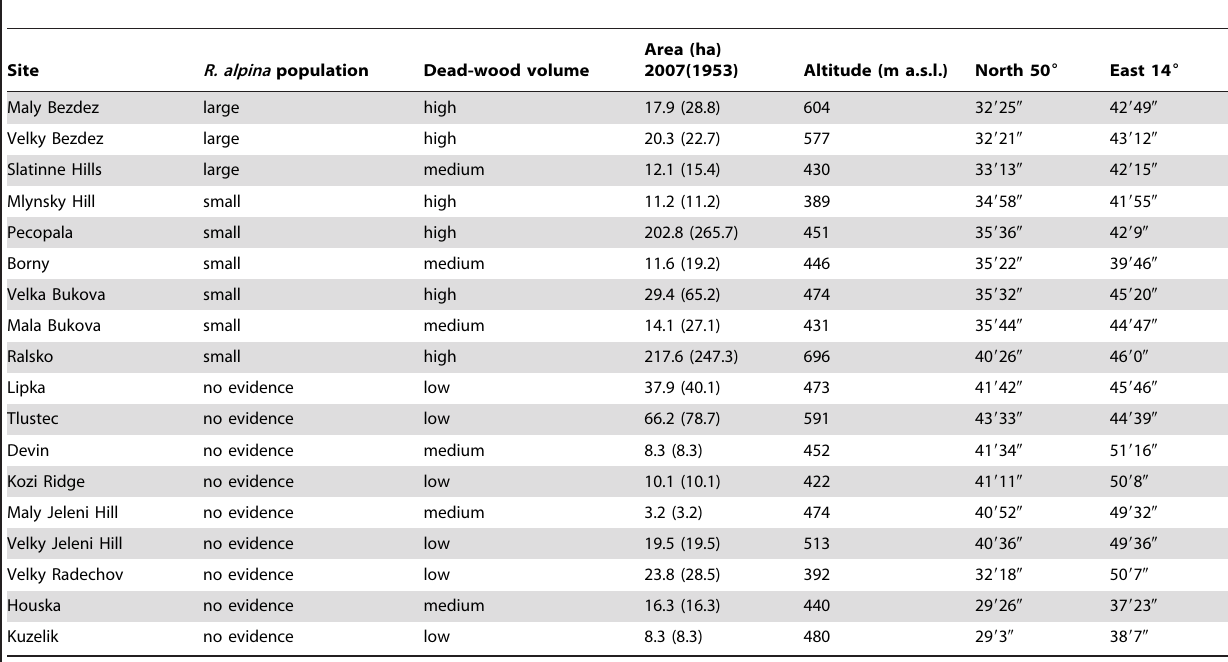
Table 4. Old beech forest patches found in the Ralska Upland, status of the Rosalia longicorn, dead-wood volume, current and historical area, altitude and geographical